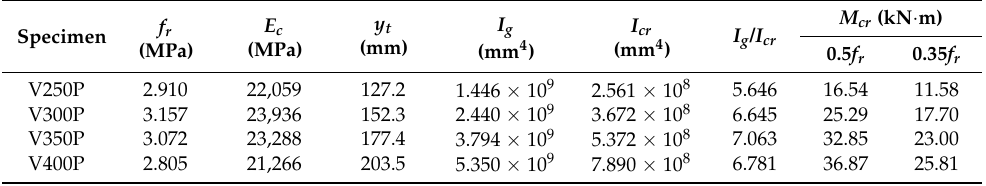
Table 3. Values of parameters used to calculate immediate deflection (V